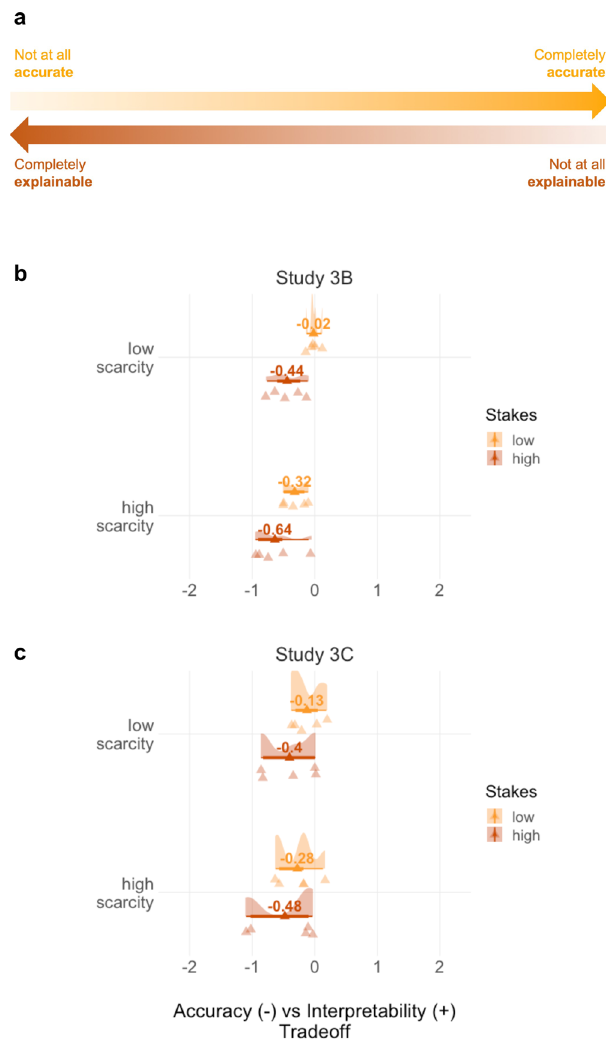
Fig. 5 | Dependent variable and results for Studies 3B and 3C. a Dependent variable on which participants were asked to move the slider to a position repre- senting their preference for the interpretability - accuracy tradeoff. The order of attributes and hence the direction of the slider was counter-balanced across par- ticipants. b Tradeoff-preferences from Study 3B ( N =112; within-subjects design), aggregating across all fi ve applications. c Tradeoff-preferences from Study 3C ( N =1344; between-subjects design), aggregating across all fi ve